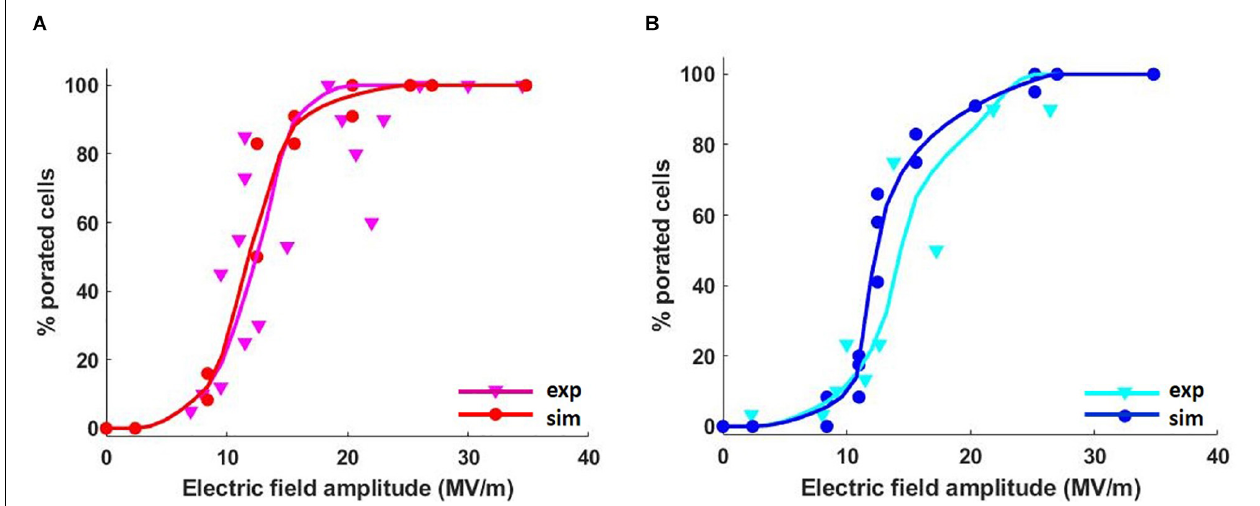
FIGURE 4 | Average percentage of the cells with porated (A) plasma and (B) ER membranes in four different mixtures as a function of the applied electric field. The red and blue curves represent the average simulated data interpolation, while the magenta and the cyan curves are the interpolation of the average experimental data. Cubic Spline Interpolation was used for both the simulated and the experimental